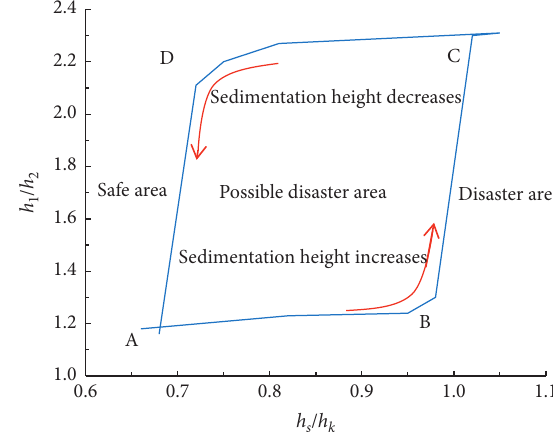
Figure 16: Division of disaster